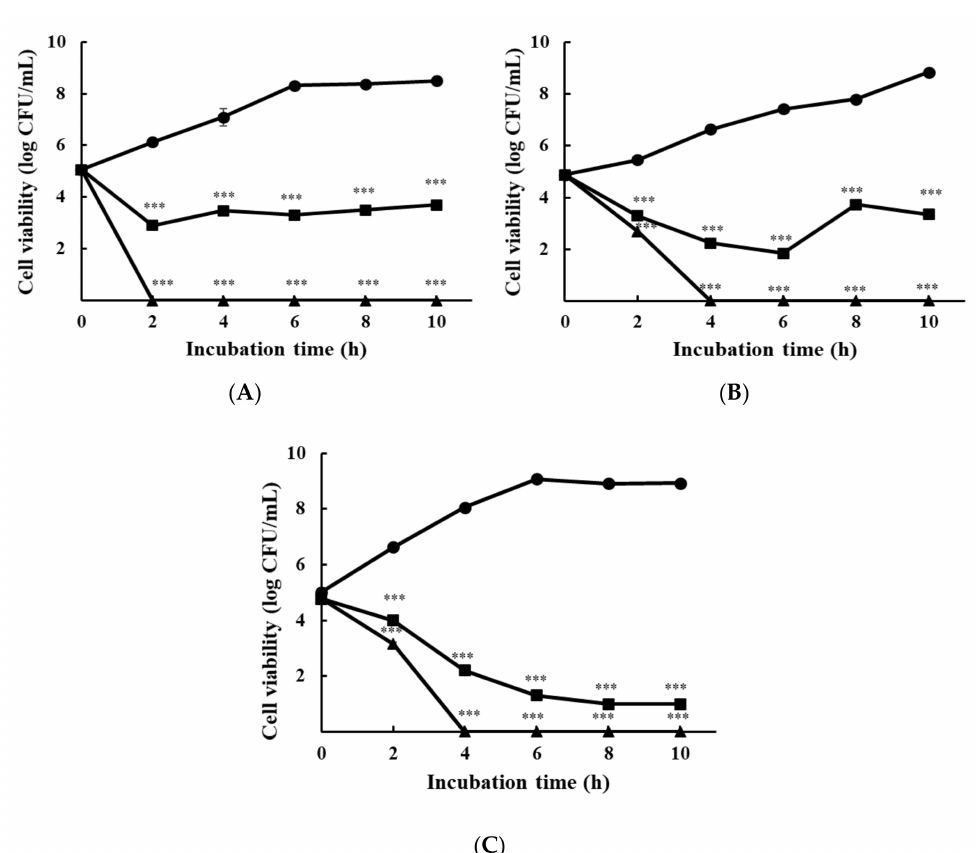
Figure 1. Time-kill analysis of ε -PL at 1/2 × MIC, 1 × MIC, and 2 × MIC against three mono-species cultured bacteria plated on TSA: ( A ) S . Enteritidis KCCM 12021; ( B ) L. monocytogenes H7962 serotype 4; and ( C ) E. coli O157:H4 FRIK 125 + E. coli ATCC 25922. All data are expressed as the mean ± standard error. Circle, Control; square, 1/2 × MIC; triangle, 1 × MIC. *** p < 0.001, compared to the control